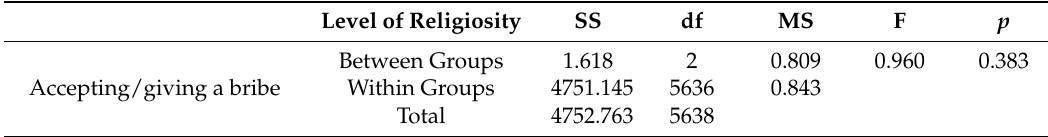
Table A12. Accepting/giving a bribe among different levels of religiosity.